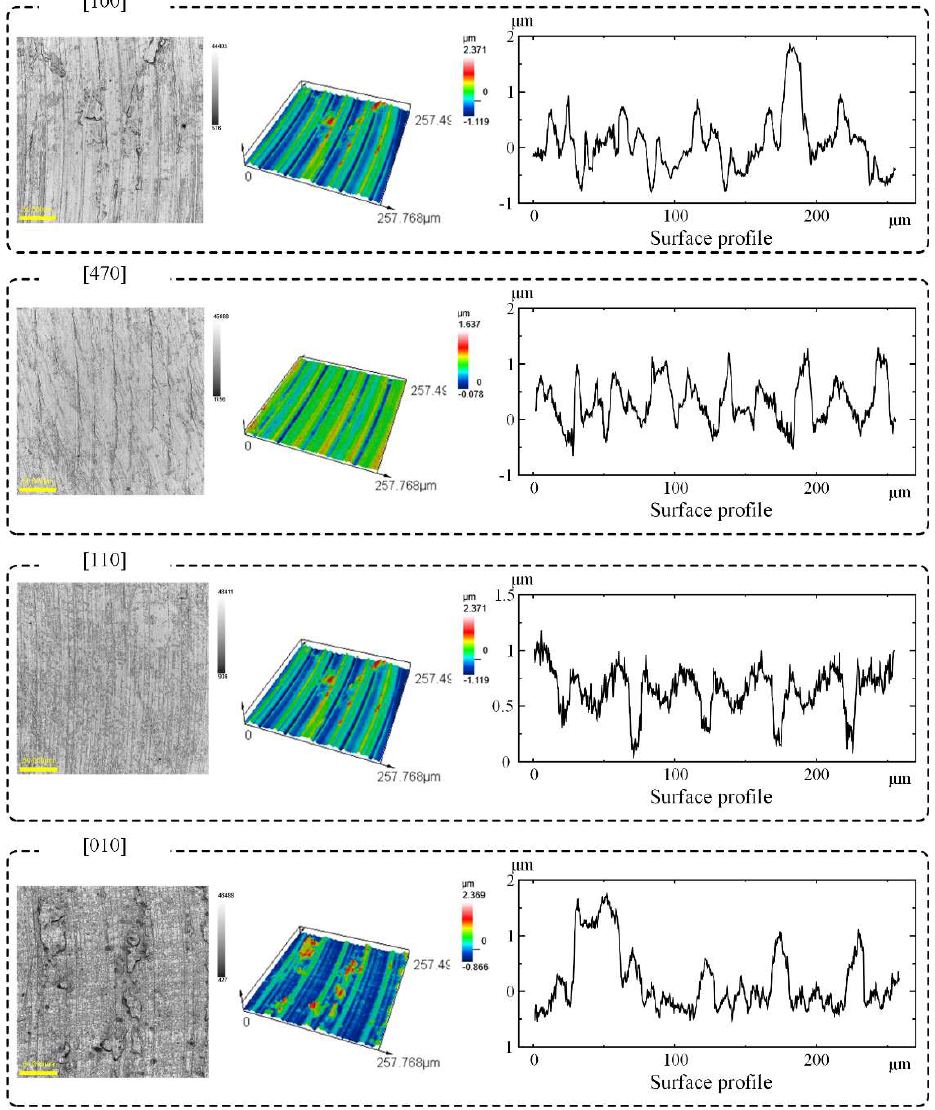
Figure 5. Surface roughness Sa of slot bottoms milled along different crystal directions.